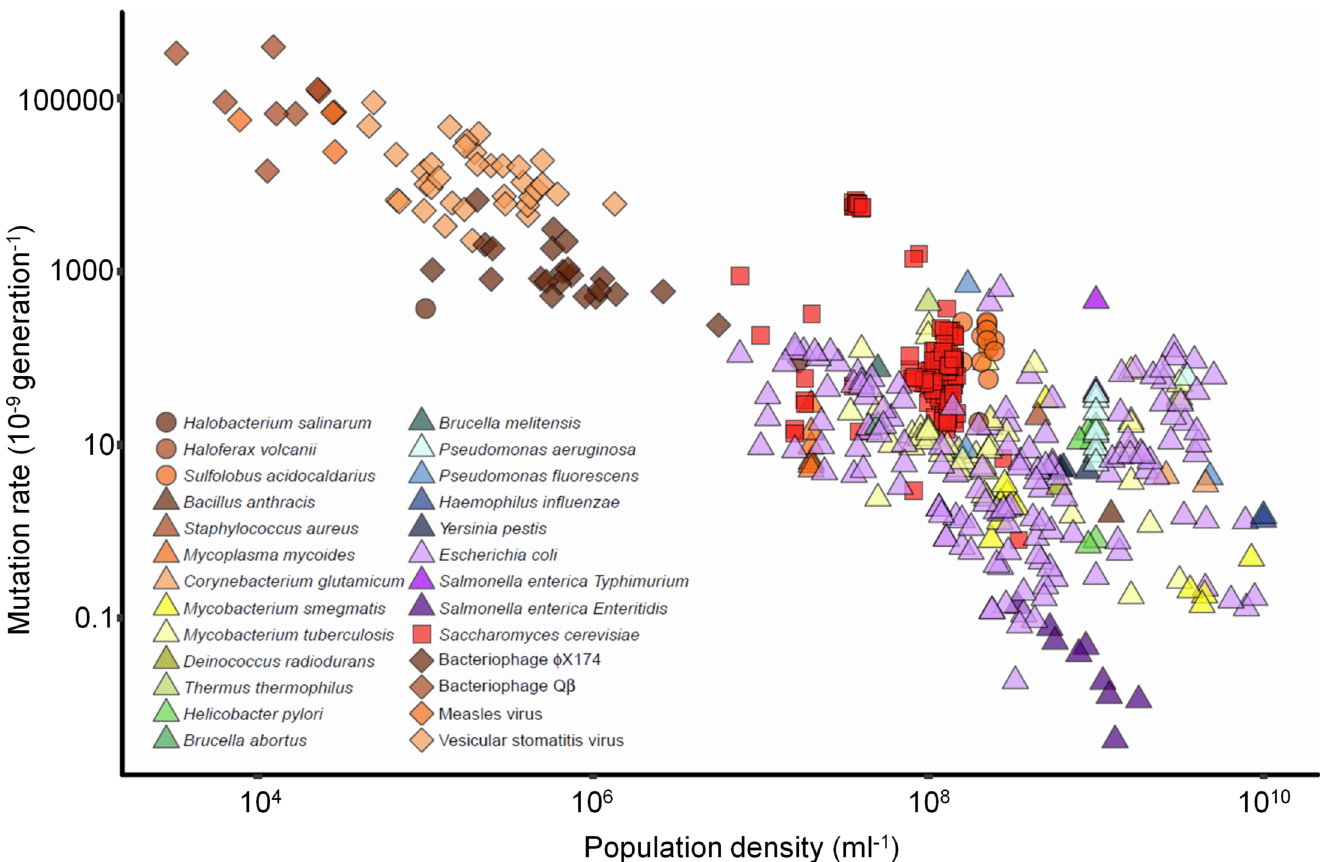
Fig 1. Mutation rates published from 1943 to 2017 in relation to population density. Colourindicatesorganism,and shape indicatesdomain: Archaea (circle), Bacteria (triangle), Eukaryota(square), and viruses/bacteriophage(diamond).Mutation rates were estimated using a wide variety of phenotypic markers ( N = 70). The genetic basis and numberof mutations giving each phenotype varies and is not known for all markers (i.e., different mutation rates may be generatedfrom the same underlying per base-pairrate). Populationdensitiesare estimated by different techniques (cell counts, colony-, or plaque-forming units). See Results, Materials and Methods, and Model S-I in S1 Text for statistical analysisaccountingfor these and other differences. Note the logarithmicaxes. Raw data is availablein S1